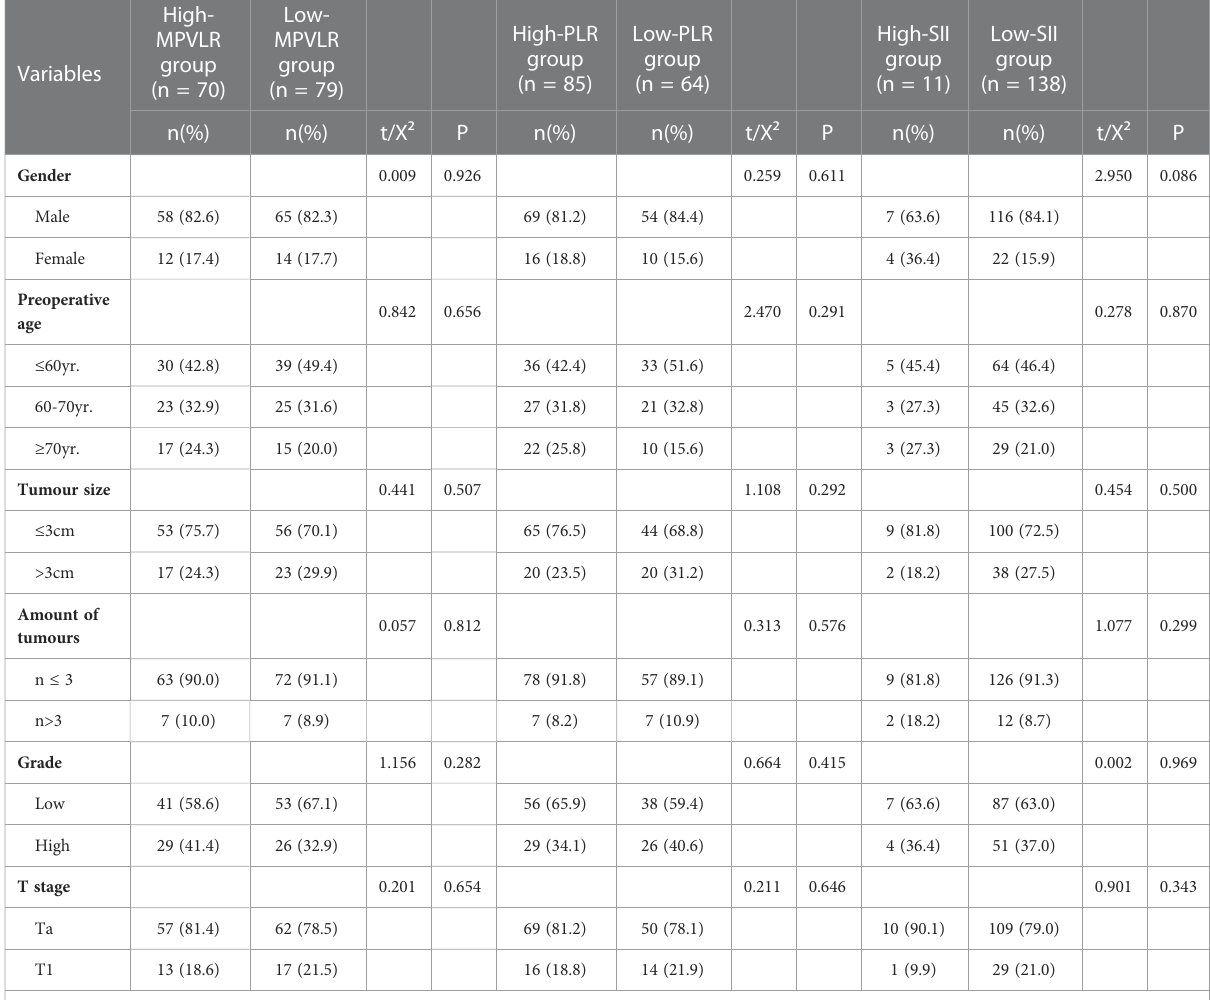
TABLE 2 Correlation between clinical data of the GEM group and PLR, SII, and MPVLR.